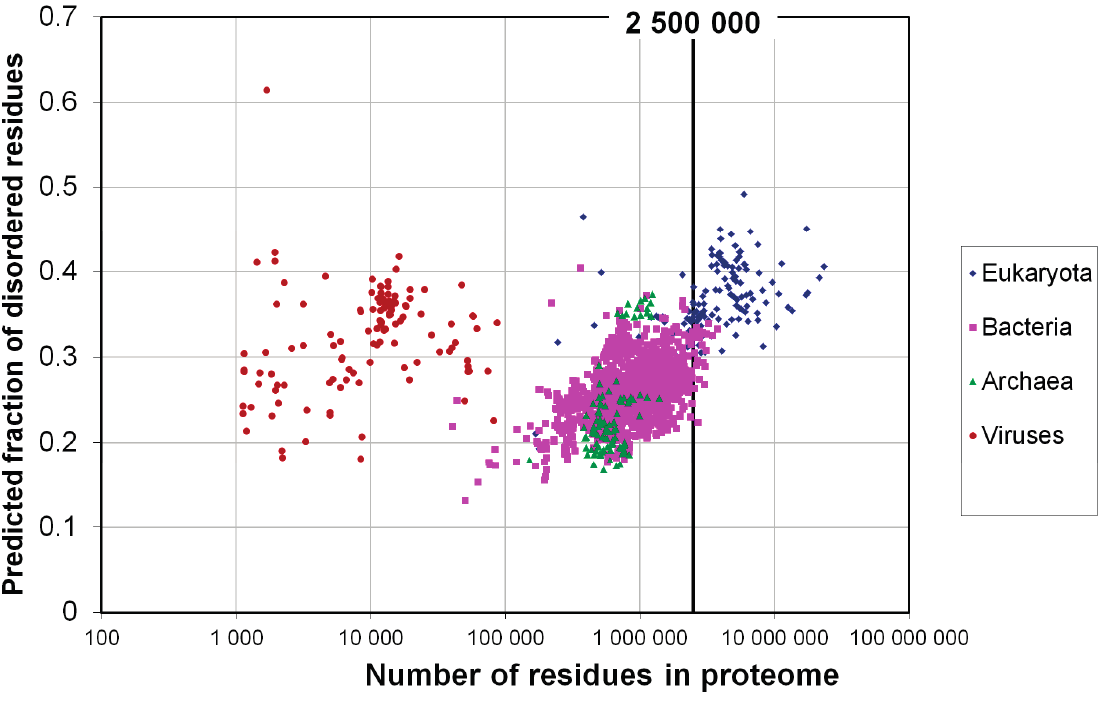
Figure 7. Predicted average fraction of disordered residues for 1902 species from eukaryotes (137), bacteria (1540), archaea (105) and viruses (120) versus the average protein length in the